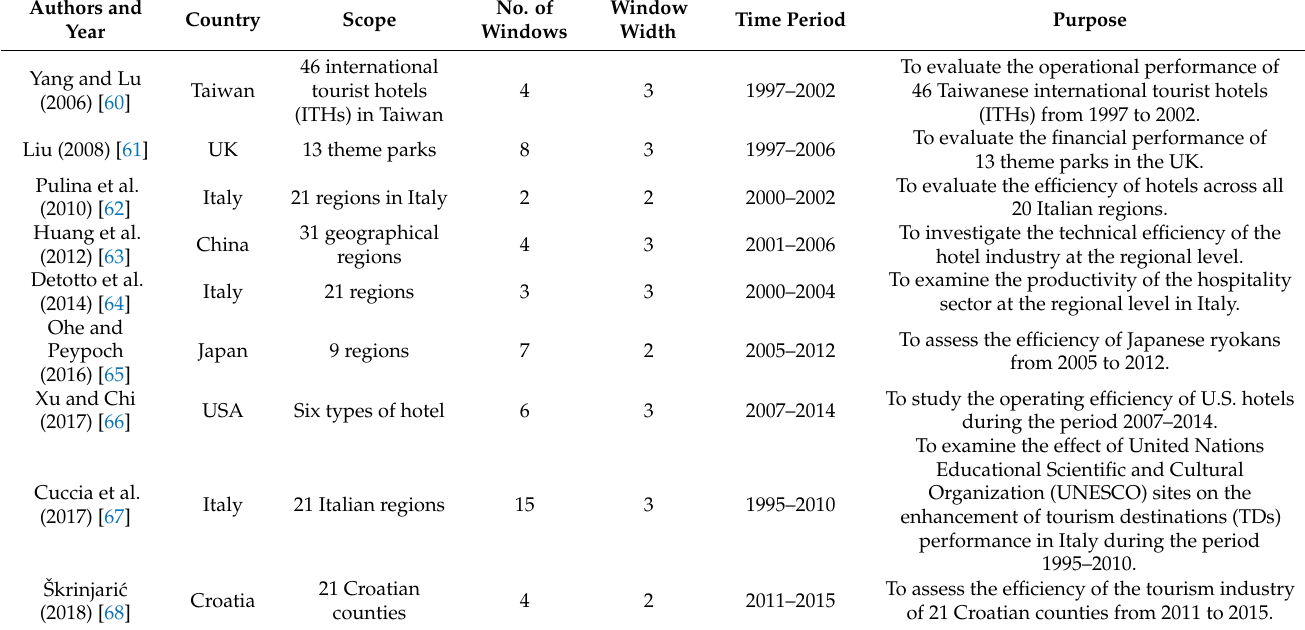
Table 6. Articles classified under the tourism category.